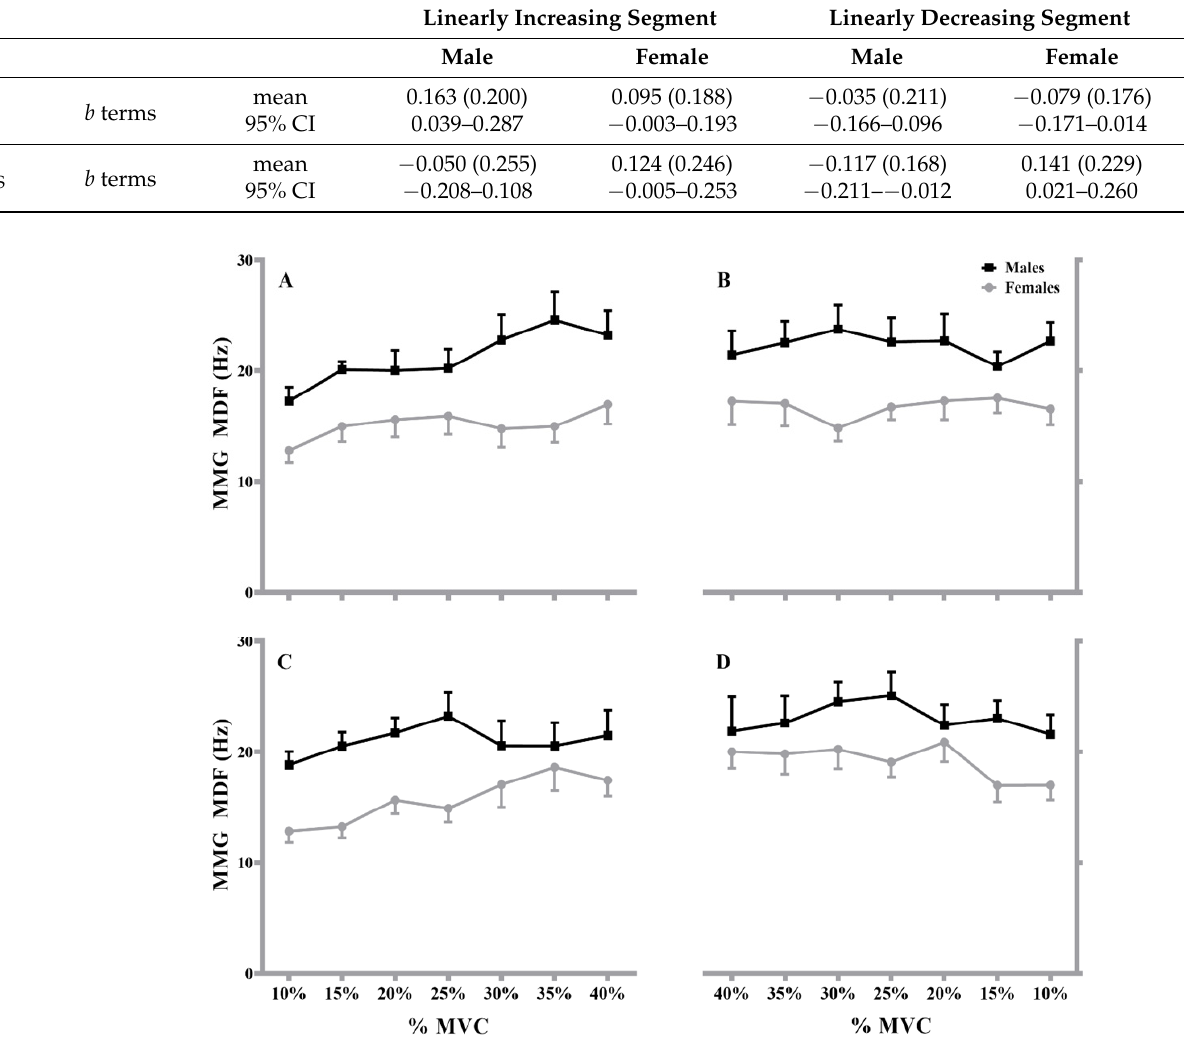
Figure 4. Plotted means with the standard error of the mean for males ( black lines ) and females ( grey lines ) during the linearly increasing ( A , C ) and linearly decreasing (B,D) segments of the mech- anomyographic median power frequency (MMG MDF )–torque relationships from 10% to 40% maxi- mal voluntary contraction (MVC) for the pre-training ( top ) and post-training absolute torque levels ( bottom